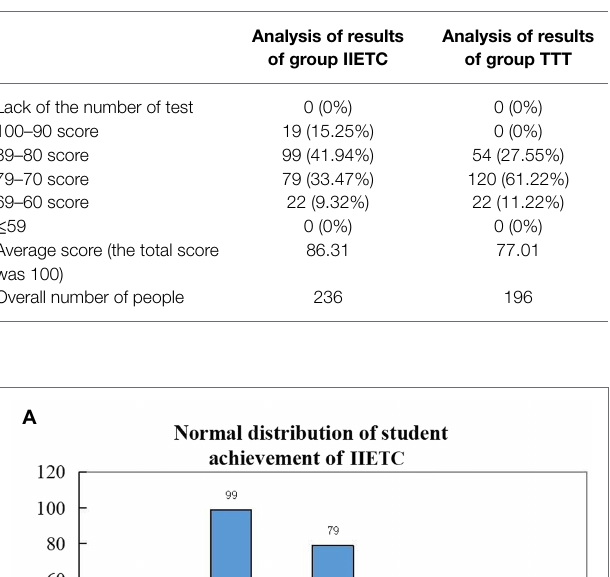
Analysis of results of group IIETC